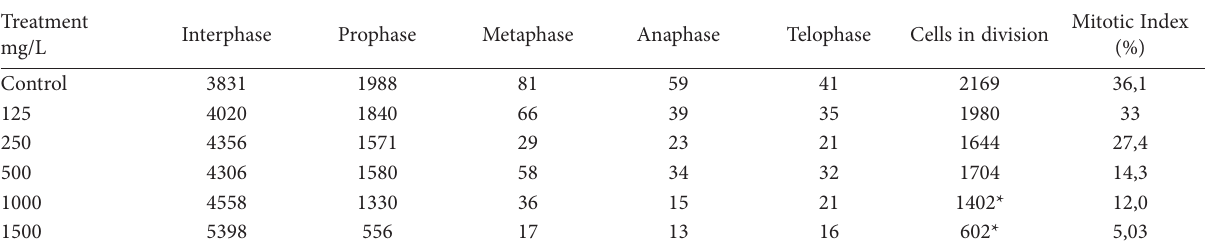
Table 2. Allium sativum merismatic cell numbers in the different cell cycle phases, and index mitotic extract of Sambucus canadensis. Treatment